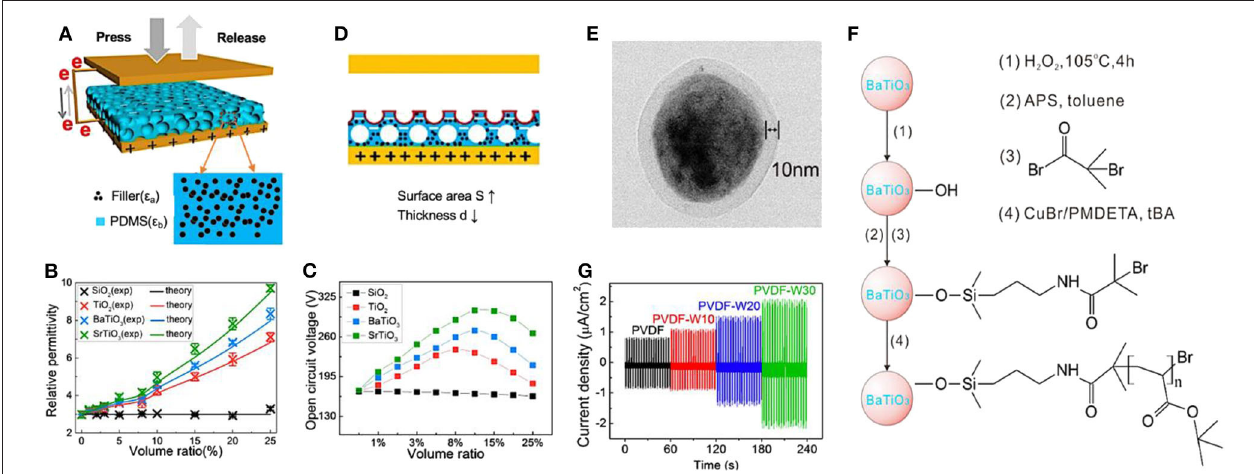
FIGURE 8 | Schematic diagrams and output performance of nanoparticles-doped TENGs. (A) Structure and working principle of as-fabricated TENG. (B) The relative permittivity and (C) open circuit voltage of TENGs fabricated with different dielectric-nanoparticles-doped PDMS films. (D) Schematic diagram of TENG with sponge structure PDMS composite film. Reprinted with permission from Chen et al. (2016a). Copyright 2016 American Chemical Society. (E) TEM images of the core-shell-structured